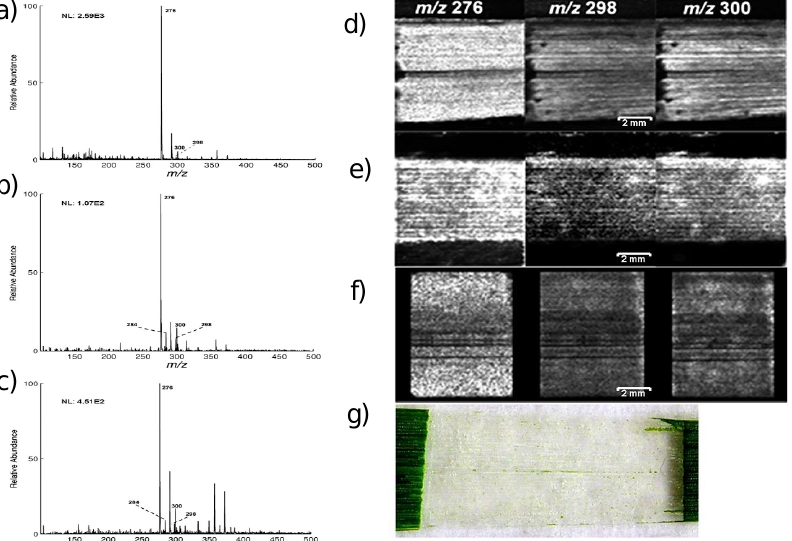
Figure 4. DESI MS spectrum and images of barley leaf under different sample preparation conditions: ( a ) DESI MS spectrum of a barley leaf (cv Mentor) treated with chloroform; ( b ) DESI MS spectrum of the Teflon imprint of the leaf epidermis; ( c ) DESI MS spectrum of the Teflon imprint of the intact leaf. DESI images are of the hydroxynitrile glucosides of m / z = 276, 298 and 300 from barley (cv Mentor); ( d ) Direct DESI images of the isolated epidermis; ( e ) Indirect DESI images of the isolated epidermis; ( f ) Indirect DESI images of the intact leaf; ( g ) Photo of the transparent leaf epidermis mounted on double-sided tape. All spectra were recorded in positive ion mode. The pixel size is 100 µ m and the acquisition times were 120 min. Figure has been adapted with permission from Li et al.